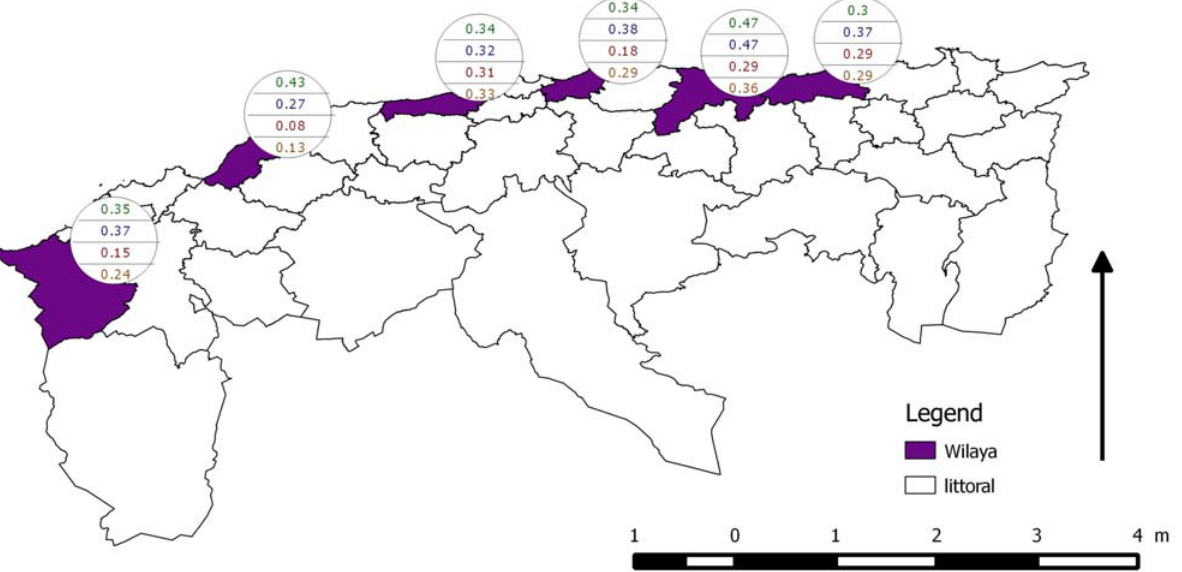
Fig 2. Apparent prevalence per test per sampling period per locality. From top to bottom: IFAT first period; IFAT second period; DAT first period; DAT second period.